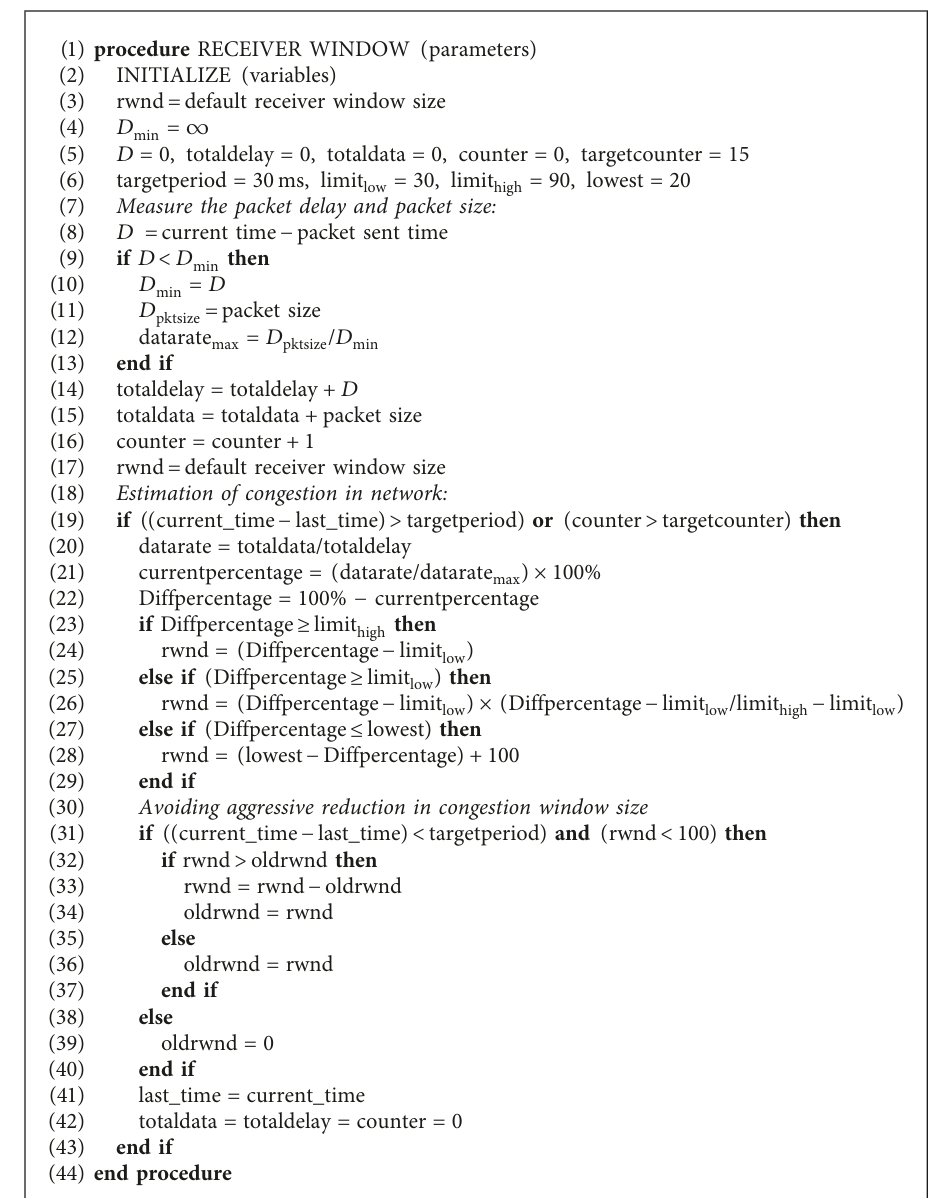
Case 2: If the difference in percentage of data rate is greater than or equal to the lower threshold limit, the traffic level is little above the normal traffic load. The rwnd value is computed based on the difference in percentage of data rate, lower threshold limit, and upper threshold limit value as shown in Algorithm 1 line number 28. This will conservatively decrease the cwnd at the sender side and result in decrease of the packet generation rate at the sender side which helps in reducing the packet delivery